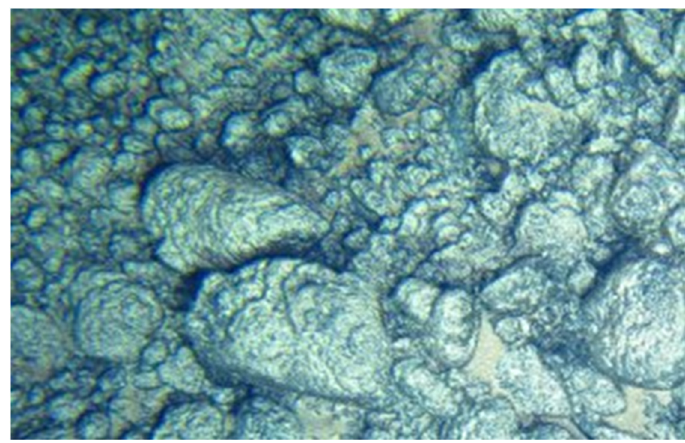
Figure 3. Cobalt-rich ferromanganese crust (Source: ISA, [18]).